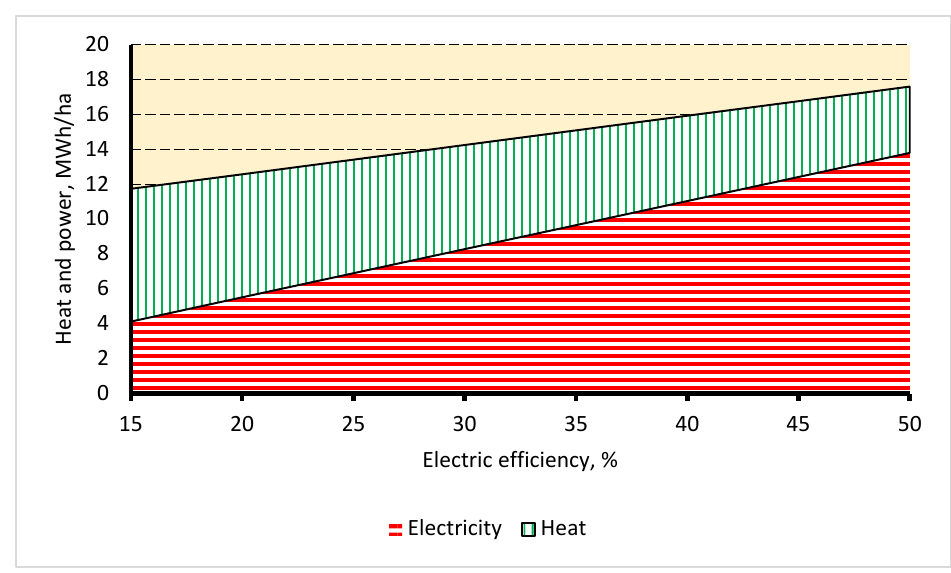
Figure 6 . Power and heat generation (methane yield is 84 m 3 /t) Figure 6. Power and heat generation (methane yield is 84 m 3 /t)